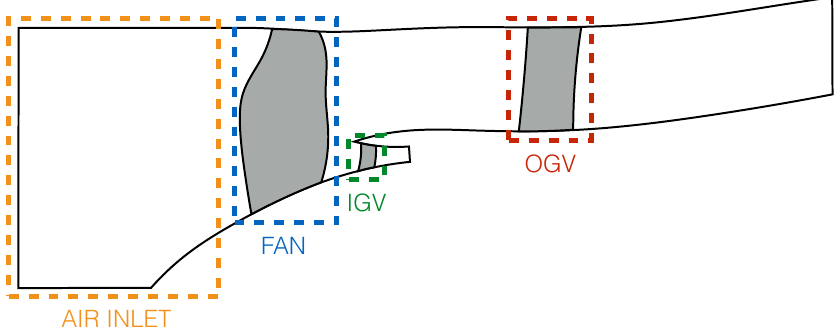
Figure 1. Meridional view of the configuration. OGV: outlet guide vane; IGV: inlet guide vane.